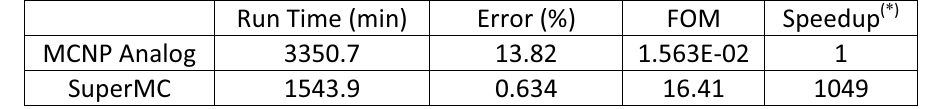
Table I. The comparison of SuperMC and MCNP calculation results in single location